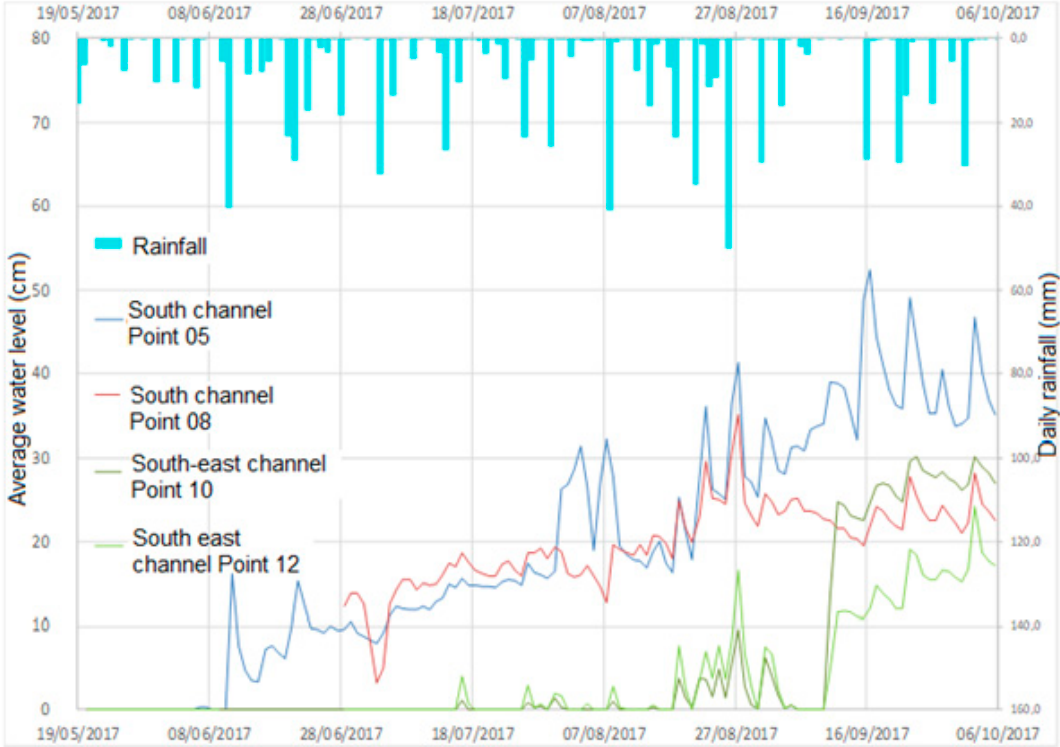
Figure A2. Comparison of the observed and required water height in the irrigation / drainage channels of Lofing inland-valley. Points represent the water level measurement locations.